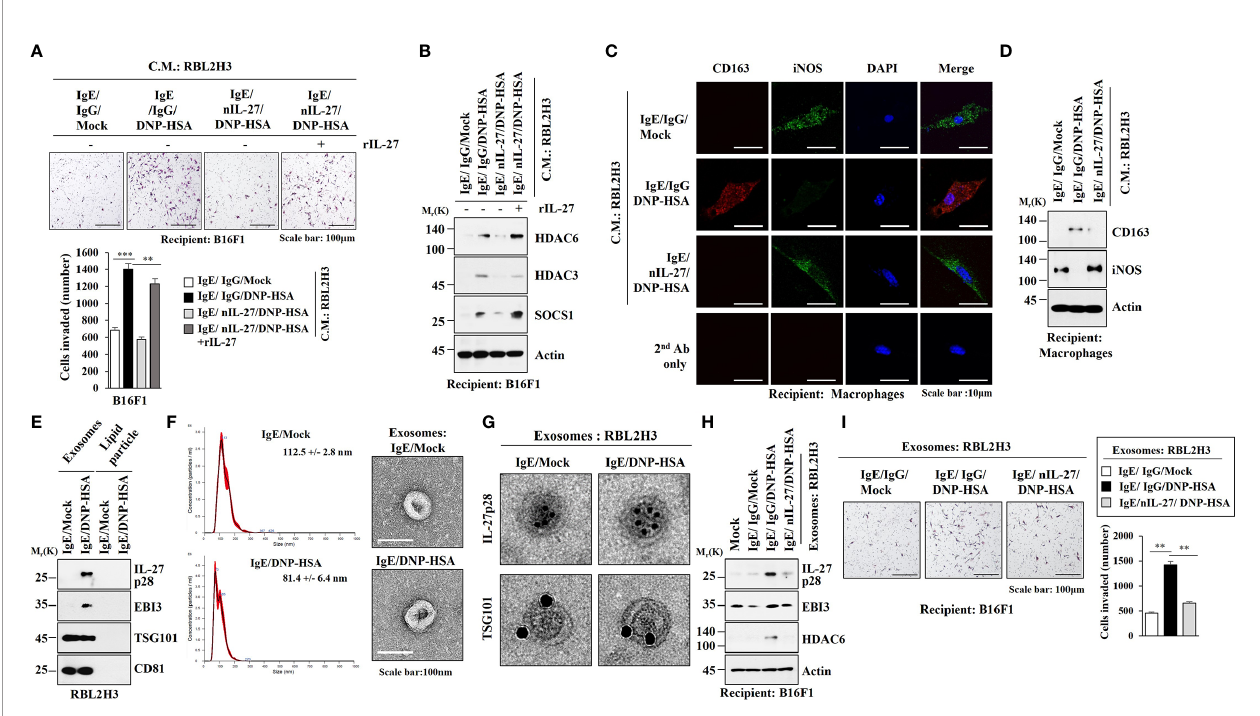
FIGURE 10 | IL-27 is present in exosomes and mediates the effects of exosomes of RBL2H3 cells on invasion of B16F1 melanoma cells. (A) RBL2H3 cells were treated with DNP-speci fi c IgE along with the indicated antibody (each at 10 m g/ml) for 24 h, and then stimulated by DNP-HSA along with rIL-27 (20 ng/ml) for 1 h. The culture medium was then added to B16F1cells for 16 h. Invasion potential of B16F1 cells was determined. ** p <0.01; *** p <0.001. Average values of three independent experiments are shown. (B) Immunoblot employing B16F1 cell lysates was performed. Representative blots of three independent experiments are shown. (C) RBL2H3 cells were treated with DNP-speci fi c IgE along with the indicated antibody (each at 10 m g/ml) for 24 h, and then stimulated by DNP-HSA. Culture medium was then added to lung macrophages for 16 h, followed by immuno fl uorescence staining. (D) Immunoblot was performed. Representative blots of three independent experiments are shown. (E) Exosomes isolated from RBL2H3 cells were subjected to immunoblot. Representative blots of three independent experiments are shown. (F) Shows size distributions of exosomes isolated from RBL2H3 cells employing nanoparticle tracking analysis (NTA). Exosomes isolated from RBL2H3 cells were observed by negative staining electron microscopy (right). (G) Immuno-gold staining images using anti-TSG101, a known membrane marker for the exosomes, and anti-IL-27 p28 antibody. Twenty- fi ve and 10 nm gold particles show the presence of TSG101 and IL-27 p28, respectively. (H) Exosomes (20 m g) isolated from RBL2H3 cells were added to B16F1 cells for 24 h. immunoblot was performed. Representative blots of three independent experiments are shown. (I) Invasion assays were performed as described. ** p <0.01. Average values of three independent experiments are